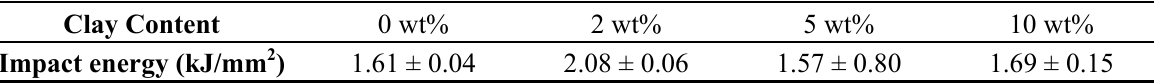
Table 5. Impact energy results for the nanocomposites cured with Lupasol